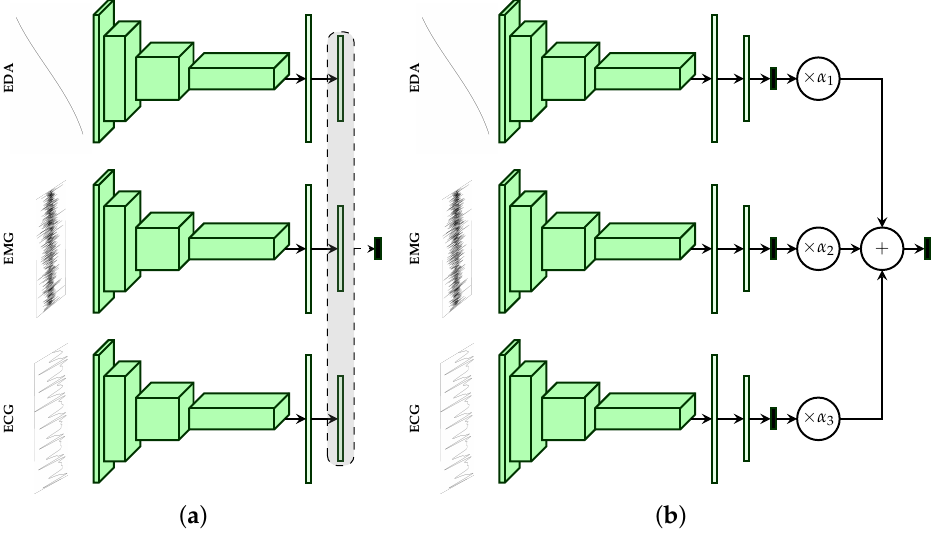
Figure 4. Late Fusion Architectures. ( a ) The features extracted by the second fully connected layer are concatenated and fed into the output layer. ( b ) The final output consists of a weighted average of the outputs of each uni-modal